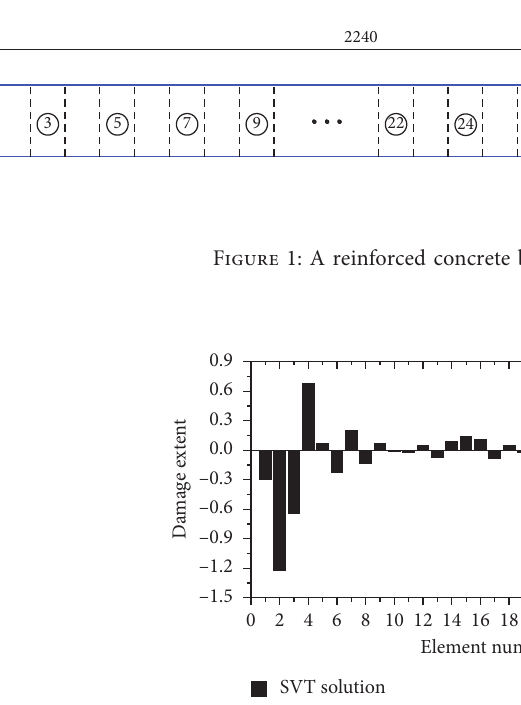
Figure 2: Damage detection result by SVT solution when element 15 is damaged.